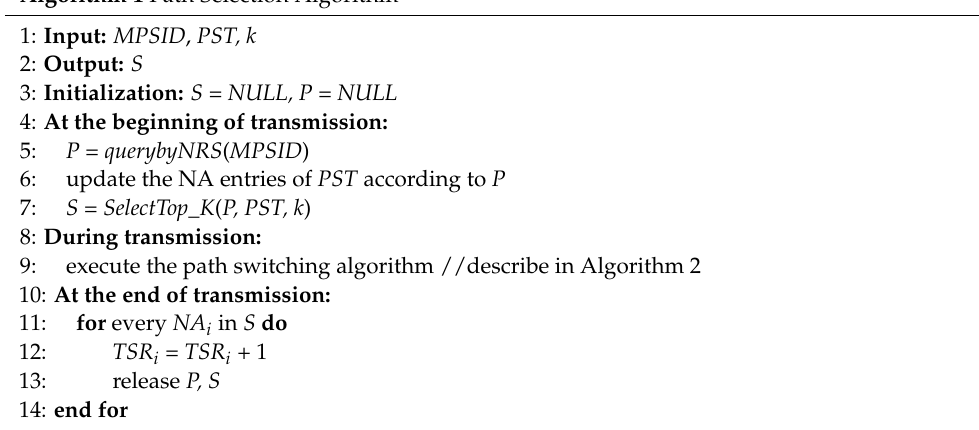
Algorithm 1 Path Selection